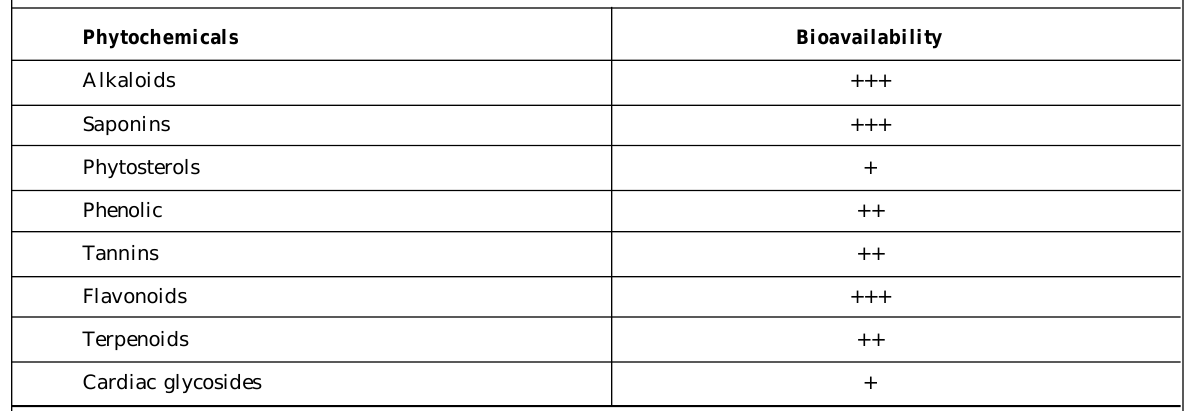
Table 1: Preliminary analysis of phytochemical contents of C.p